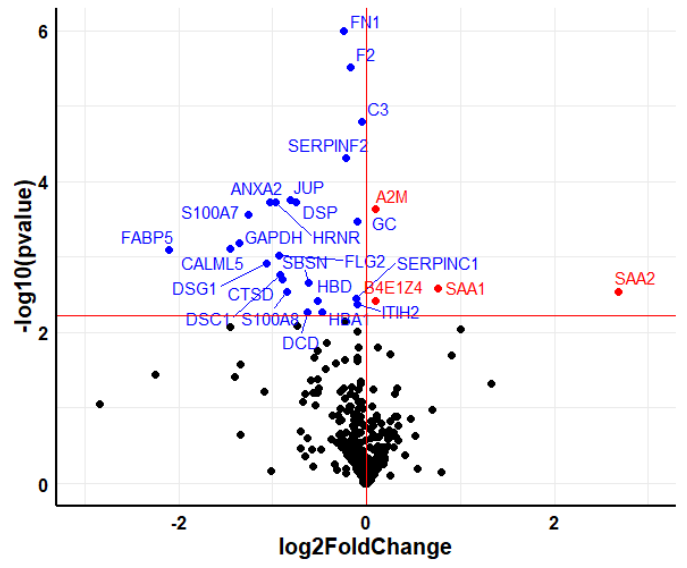
Figure 1. Volcano plot showing the differentially expressed proteins in serum after 6 months of treatment with teriparatide. The upregulated proteins are colored in red, whereas the downregulated proteins are colored in blue. Horizontal red line marks the q-value threshold (0.05). Black circles are those proteins under the q-value threshold (not significant).